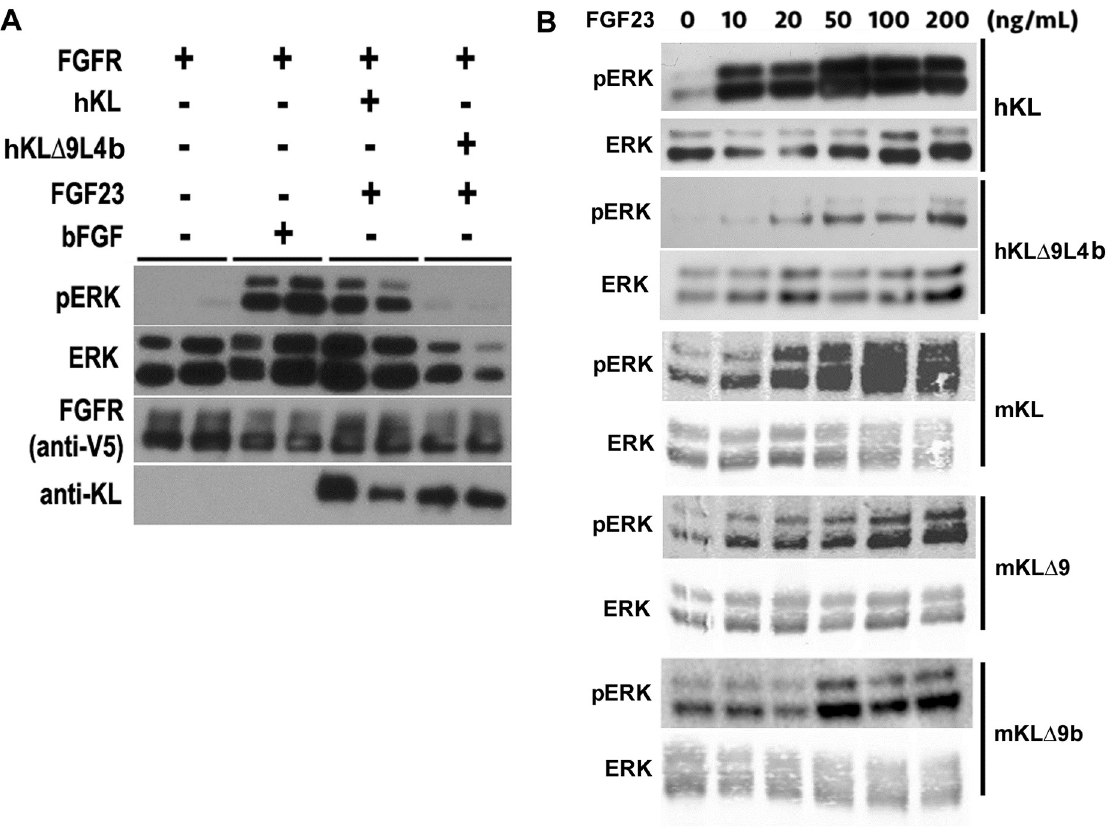
Fig 4. FGF23 signaling activity of Klotho mutants. A. Western Blot showing differences in ERK phosphorylation compared to total expression of ERK after transfection of the V5-tagged FGF receptor and KL WT or KL Δ 9L4b. Cells were treated with 10 ng/mL FGF23 for 30 minutes. bFGF is used as positive control for ERK phosphorylation. Arrow marks the reduction in the pERK doublet by KL Δ 9L4b relative to KL WT. B. High concentrations of FGF23 increases ERK phosphorylation in mouse and human KL mutants. Western Blot of HEK-293 cells transfected with human and mouse Klotho mutants with different doses of FGF23 for 15 minutes. Western Blotting was performed with either pERK or total ERK antibodies.